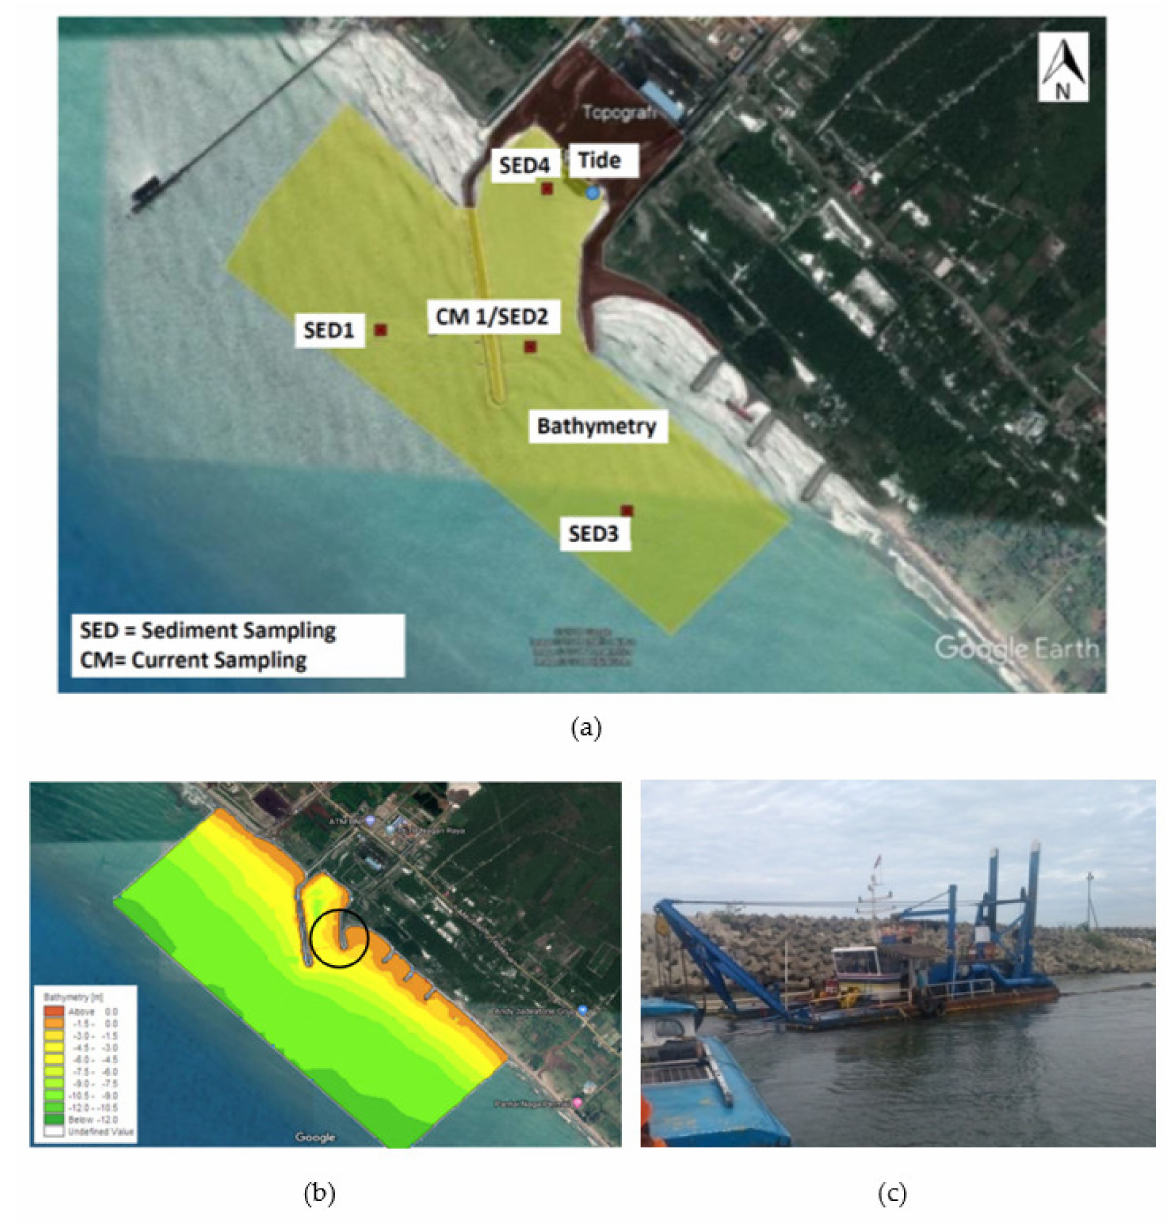
Figure 2. ( a ) Hydrographic Survey Area. ( b ) Bathymetric map of Nagan Raya port from 2018. ( c ) Dredging activity at port